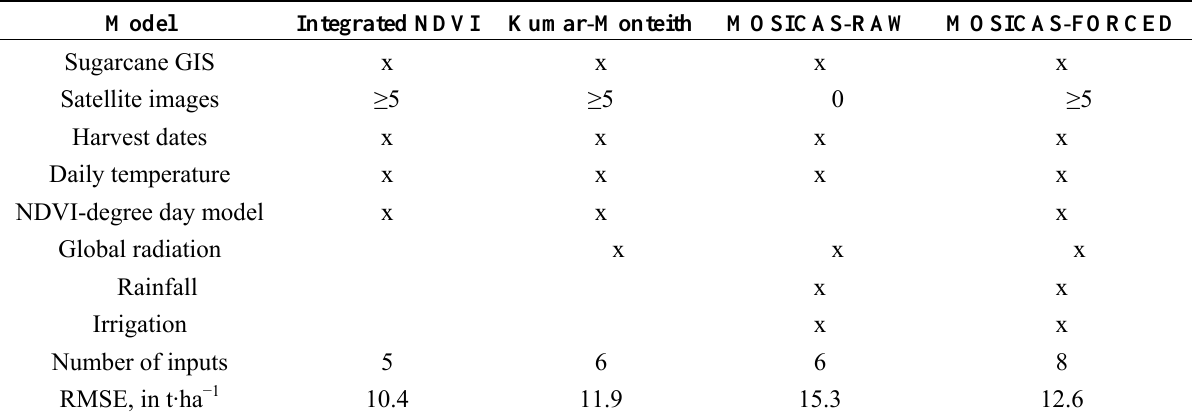
Table 1. Comparison of the requirements and accuracy of each